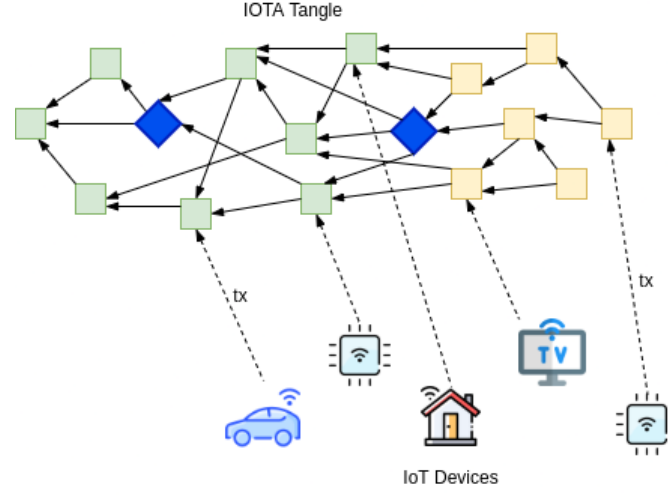
Figure 3. IoT devices interacting with IOTA ledger.